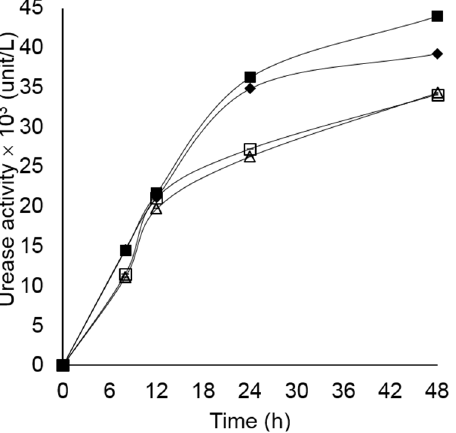
Figure 3. Urease activity of Lysinibacillus sp. 2.2 ( △ ), L . fusiformis 3.7 ( □ ), L. xylanilyticus 4.3 ( ♦ ), and L. fusiformis 5.1 ( ■ ) grown on TSB supplemented with 2% urea at 150 rpm, 28 °C for 48 h. Values are mean ± SD. The SD value was shown in supplementary Table S2.